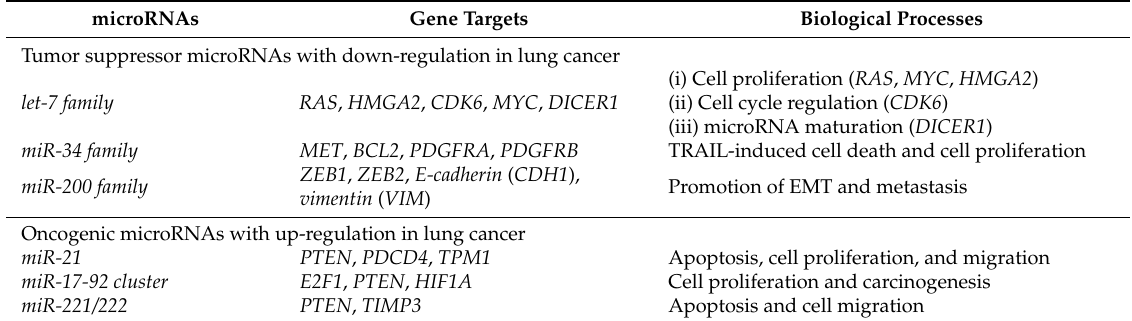
Table 1. Principal microRNAs involved in the development or progression of lung cancer. microRNAs